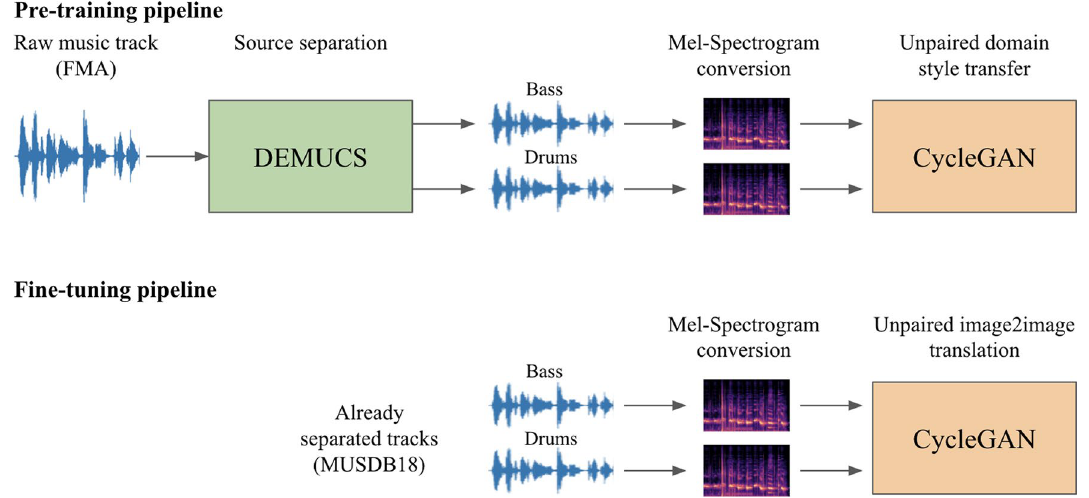
Fig. 1 To solve the automatic drum arrangement task, we tested an unpaired image-to-image translation strategy known as CycleGAN [7]. In particular, we trained a CycleGAN architecture on 5s bass and drum samples (equivalent to 256 × 256 mel-spectrograms) coming from both the Free Music Archive (FMA) dataset [8] and the musdb18 dataset [9]. Since the FMA songs lack source-separated channels (i.e., dif- ferentiated vocals, bass, drums, etc.), the bass and drum channels were extracted using Demucs [10]. After the source separation task on our song dataset, the bass and drum waveforms are turned into the corresponding mel-spectrograms. The sampling rate was set to 22050 Hz, the window length N to 2048, the number of mel-frequency bins to 256, and the hop size H to 512. To fit our model requirements, we cropped out 256 × 256 windows from each mel-spectrogram with an overlapping of 50-time frames, obtaining multiple samples from each song (each roughly equivalent to 5 s of music). Since FMA is much larger than musdb18 but also lower quality due to the artificial separation of sources, we used FMA to train the model, and then we fine-tuned it with musdb18, which comes in a source-separated